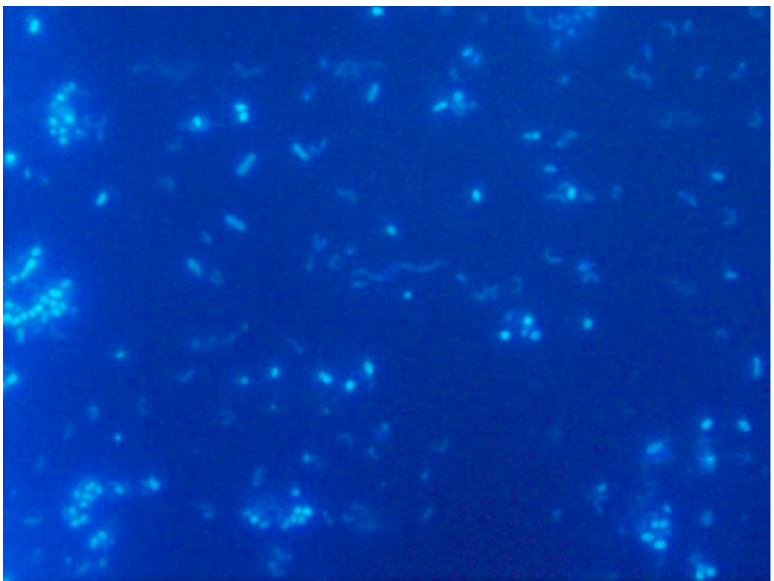
Figure 5. DAPI staining performed on a mouse gut sample. Visible cocci, rods, curved rods (possibly Desulfovibrio ) and spiral-shaped cells (own micro-photograph).